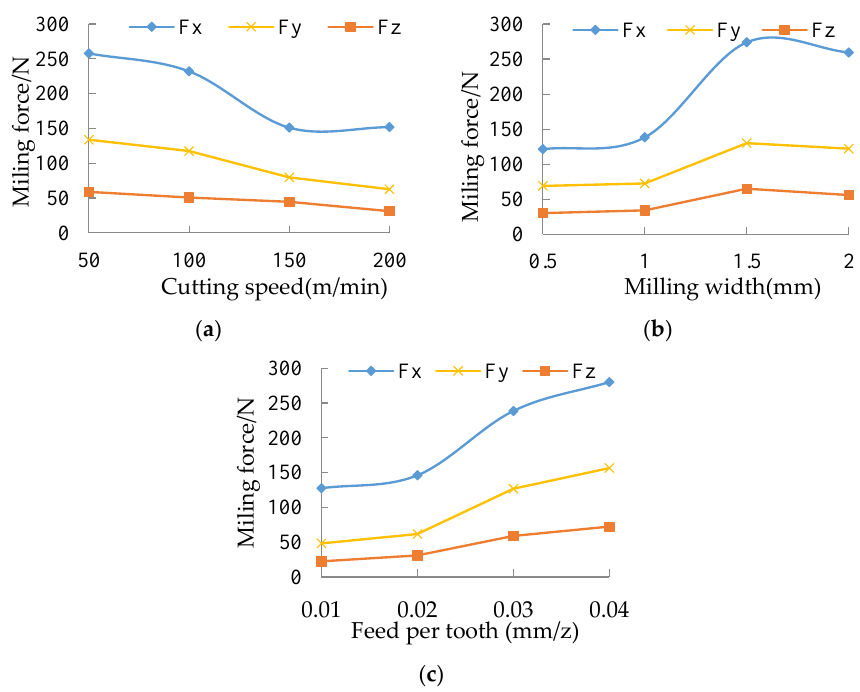
Figure 8. Milling parameters versus milling forces: ( a ) Cutting speed versus cutting forces; ( b ) Milling width versus mil forces; ( c ) Feed per tooth versus milling forces.